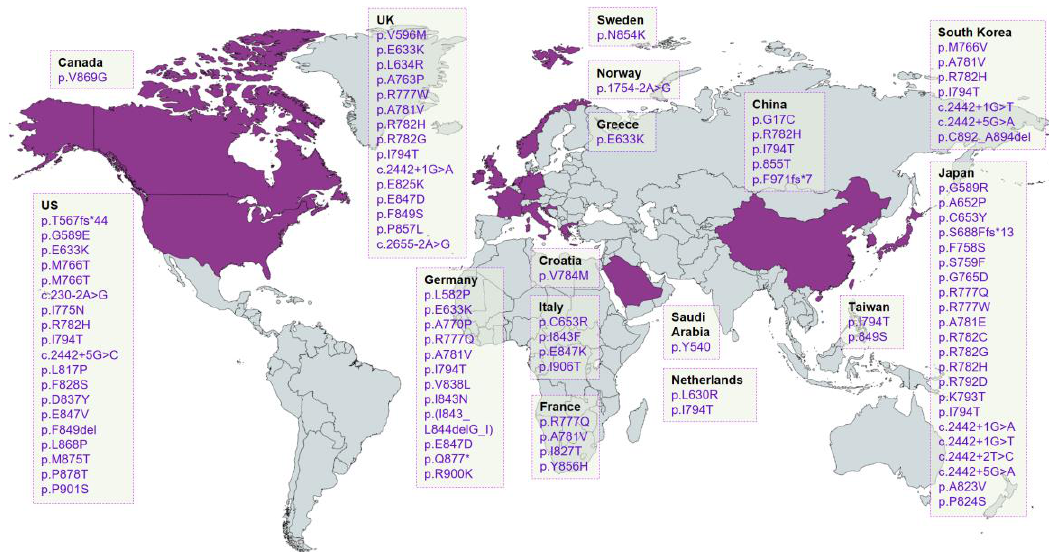
Figure 3. Worldwide distribution of CSF1R mutations. The countries in which the mutation was reported were shown in purple. This world map was created using mapchart (http://mapchart.net/).